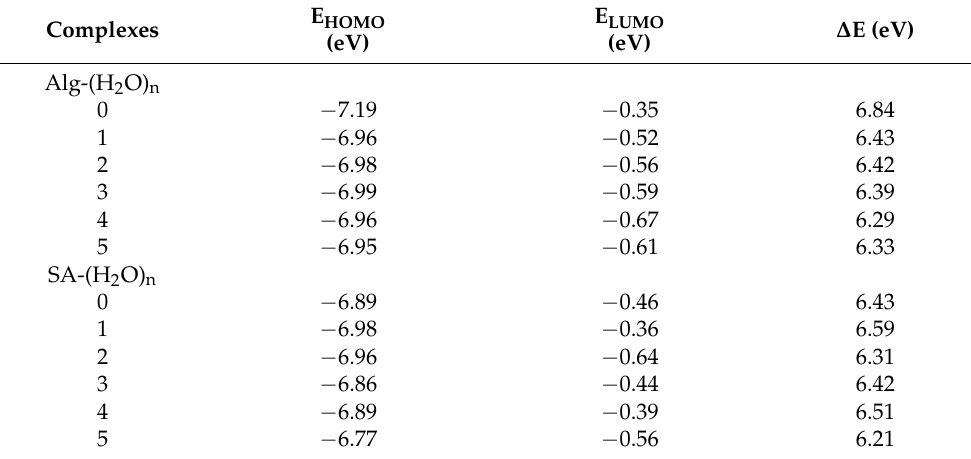
Table 3. The chemical descriptors of the